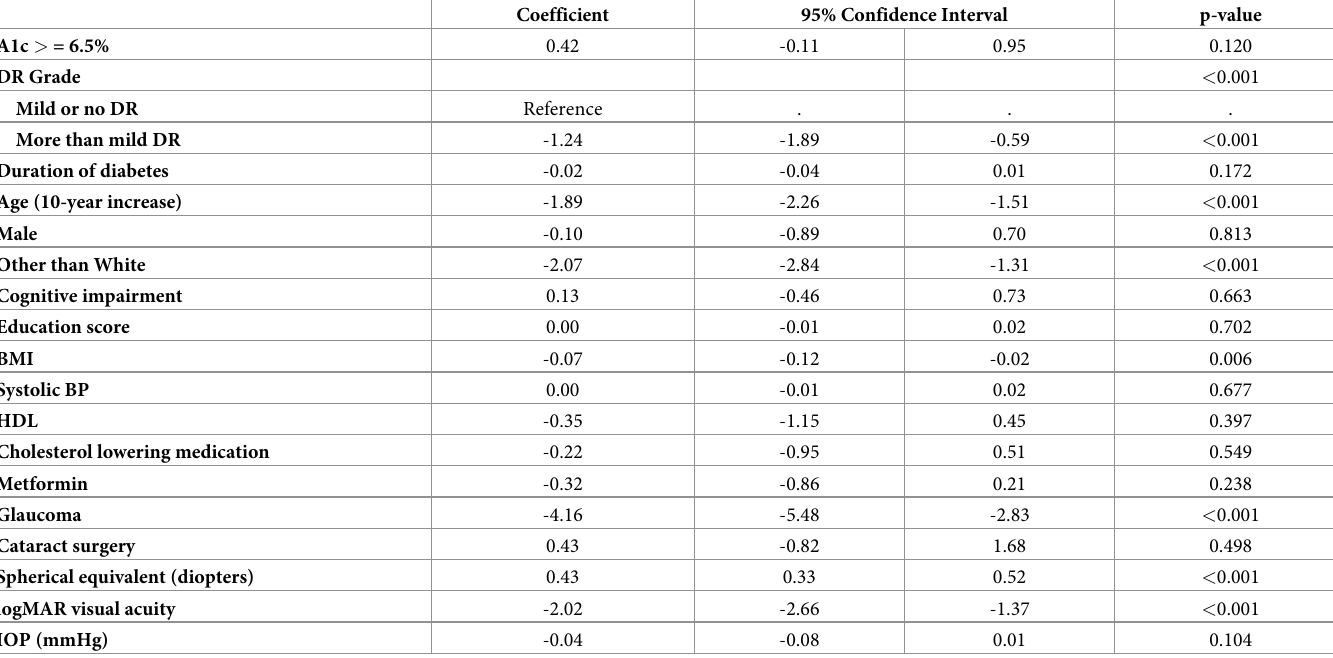
Table 4. Multivariable general linear mixed model for GC-IPL thickness among participants with